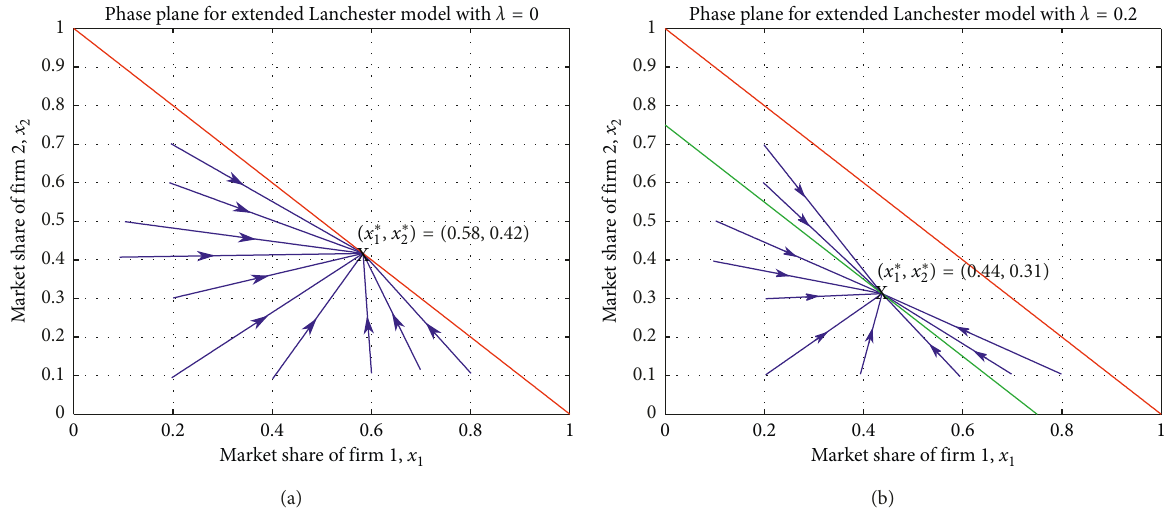
Figure 3: Phase plane of the market shares of firms x � 0 . 35 for firm 1 and c c 1 Note the change in the line containing the equilibrium points. In this case, the new equation of line is x